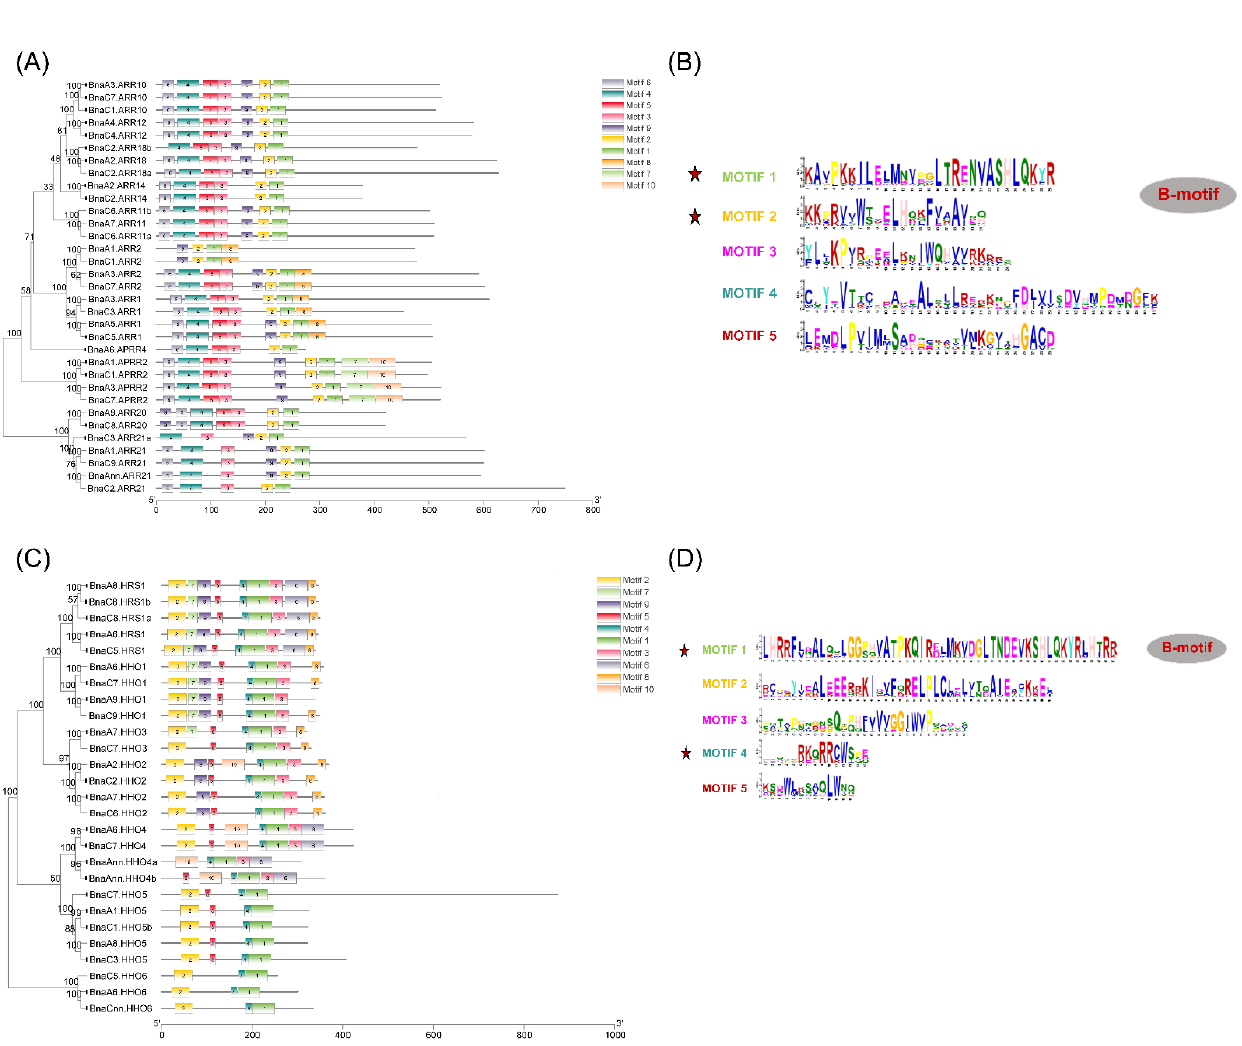
Figure 2. Identification and characterization of the conserved motifs in the GARP proteins in B. napus . ( A ) Molecular identification of BnaARR-Bs . ( B ) The sequence characterization of BnaARR-Bs . ( C ) Molecular identification of BnaNIGT1/HRS1/HHOs . ( D ) The sequence characterization of BnaNIGT1/HRS1/HHOs . In A and C, the boxes with different colors indicate different conserved motifs (motifs 1 – 10), and black lines represent the GARP protein regions without detected motifs. In C and D, the larger the fonts, the more conserved the motifs. Among them, the tagged motifs were identified as the